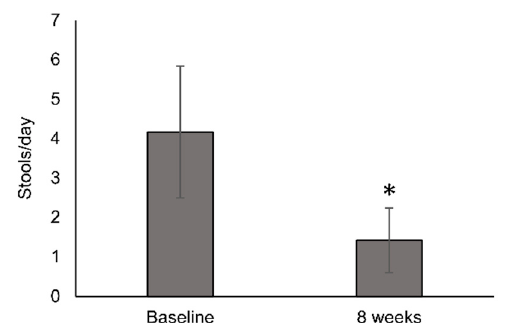
Figure 4. Change in stool frequency after 8 weeks of oligomeric enteral nutrition (OEN) treatment. The bars show mean ± SD stools / day at baseline and after 8 weeks of OEN treatment. The change in stool frequency from baseline to week 8 was statistically significant ( p = 0.0041). * mean the statistical significance ( p = 0.0041).